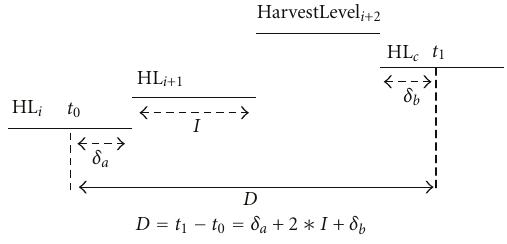
Figure 11: The energy harvesting concept in the Castalia